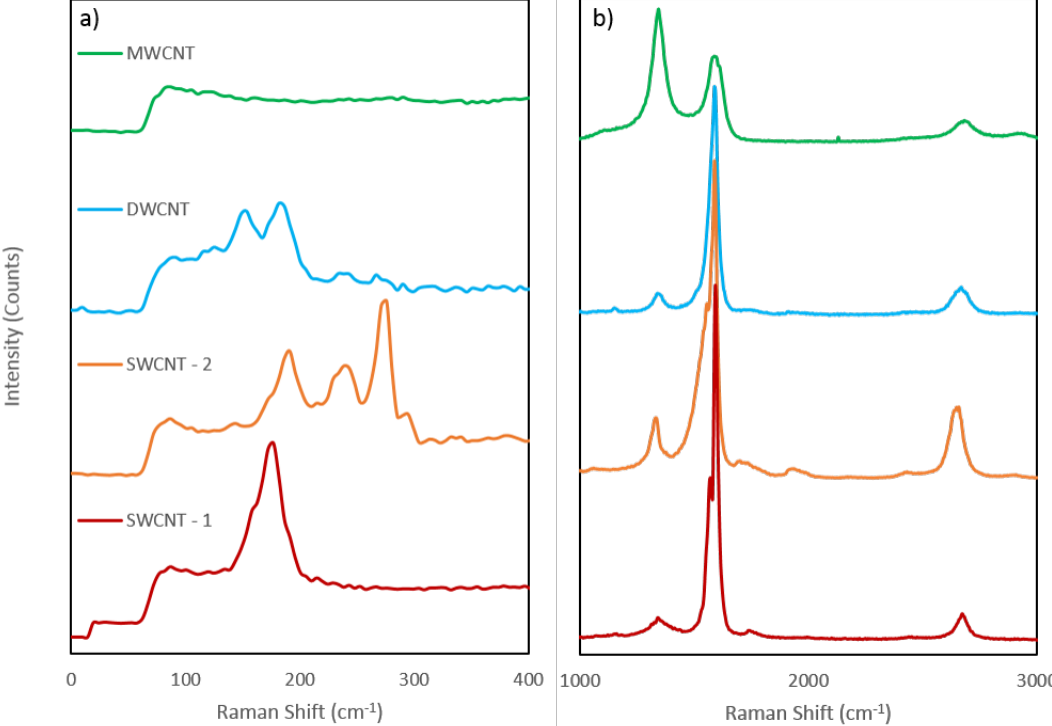
Figure 3. ( a ) Low wavenumber region of the Raman spectra for all CNT samples showing the D, G, G and Breit-Wigner-Fano (BWF) bands, the intensity values have been offset to allow for easier viewing. ( b ) High wavenumber region of the Raman spectra for all CNT samples, showing the radial breathing mode (RBM) region. The intensity values have been offset to allow for easier